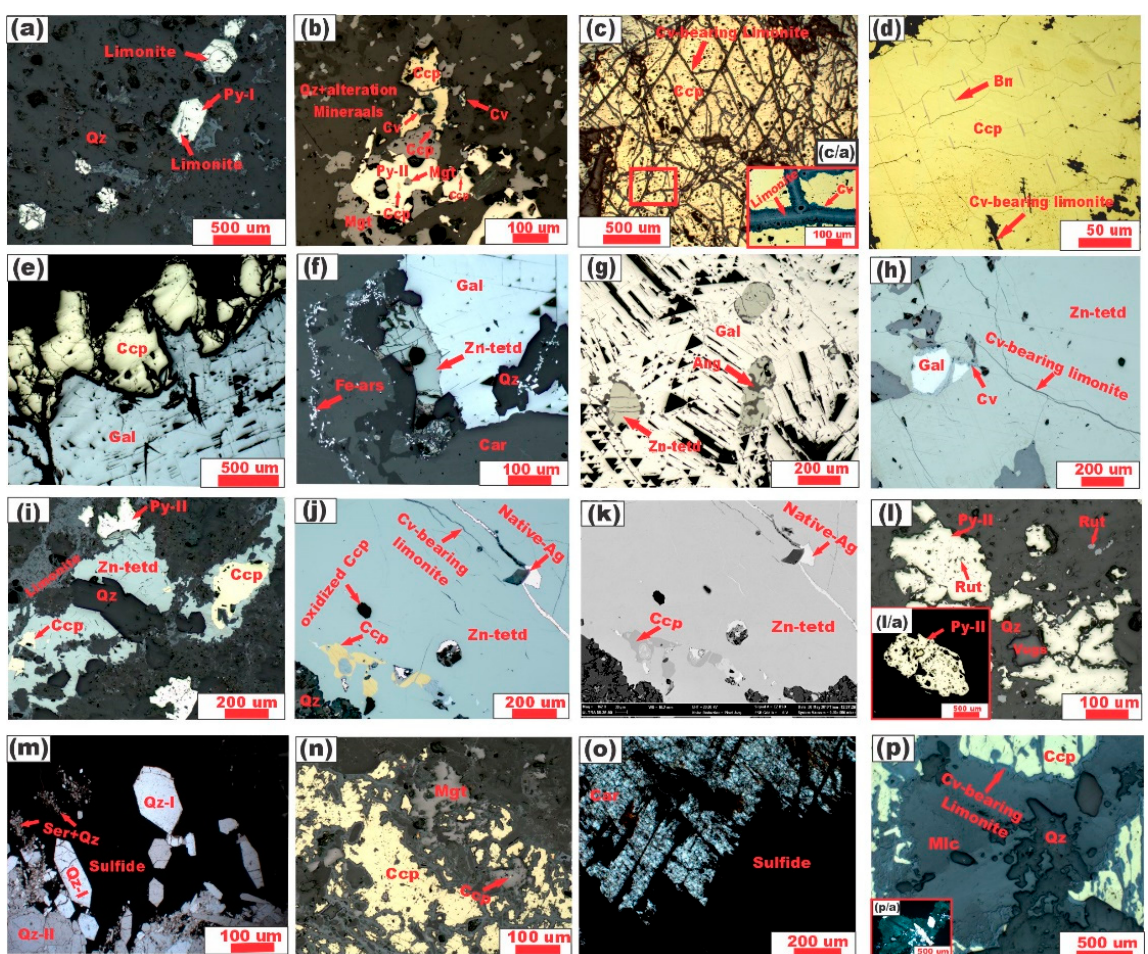
Figure 5. Ore mineralogy of different mineralization stages (reflected plane-polarized light, transmitted plane and cross- polarized light, and back-scatt ered electron images): ( a ) Euhedral Py-I is usually replaced by limonite; ( b ) Py-II replaces chalcopyrite and magnetite in open space filling texture in quartz and alteration zone, while magnetite also replaces chalcopyrite and chalcopyrite replaced by covellite; ( c ) massive chalcopyrite is replaced by covellite-bearing limonite veinlets; (c/a) high magnification of red box area is marked in Figure 3c; ( d ) oriented bornite exsolution lamellae within massive chalcopyrite; ( e ) galena filling the microfractures of chalcopyrite as open space texture; ( f ) galena coexisting with zincian-tetrahedrite, and Fe-arsenide infill microfractures among quartz and carbonate; ( g ) bleb of zincian-tetrahedrite within massive galena as contemporaneous and both replacing by anglesite along the cleavage gaps and micro cracks; ( h ) massive zincian tetrahedrite replacing relict-grained galena and itself replaced by covellite-bearing limonite; ( i ) Chalcopyrite and Py-II and are replacing by massive zincian tetrahedrite as open space texture in quartz; ( j ) native-silver filling the fractures and microcracks within massive zincian tetrahedrite, chalcopyrite also observed as inclusion; ( k ) same sample of Figure 3j in back-scattered electron image; ( l ) rutile coexisting as inclusion in Py-II and quartz; ( m ) doubly terminated euhedral quartz floating in sulfide ore, while fine grain sericite and quartz aggregates filling interstices (PPL); ( n ) chalcopyrite is replaced by magnetite, fine grain pseudomorph of chalcopyrite is observable within magnetite; ( o ) contact boundary between sulfide and carbonate mineral (transmitted PPL); ( p ) malachite replacing chalcopyrite (supergene alteration) and itself replaced by covellite-bearing limonite (reflected PPL); (p/a) same sample of Figure 3 in transmitted PPL, showing green internal reflection of malachite. Py, pyrite; Ccp, chalcopyrite; Gal, galena; Zn, tetd (zincian-tetrahedrite); Bn, bornite; Mgt, magnetite; Cv, covellite; ML, malachite; Rut, rutile; Car, carbonate; Qz, quartz; Ser, sericite; Fe, ars (Fe-arsenide); Ang,